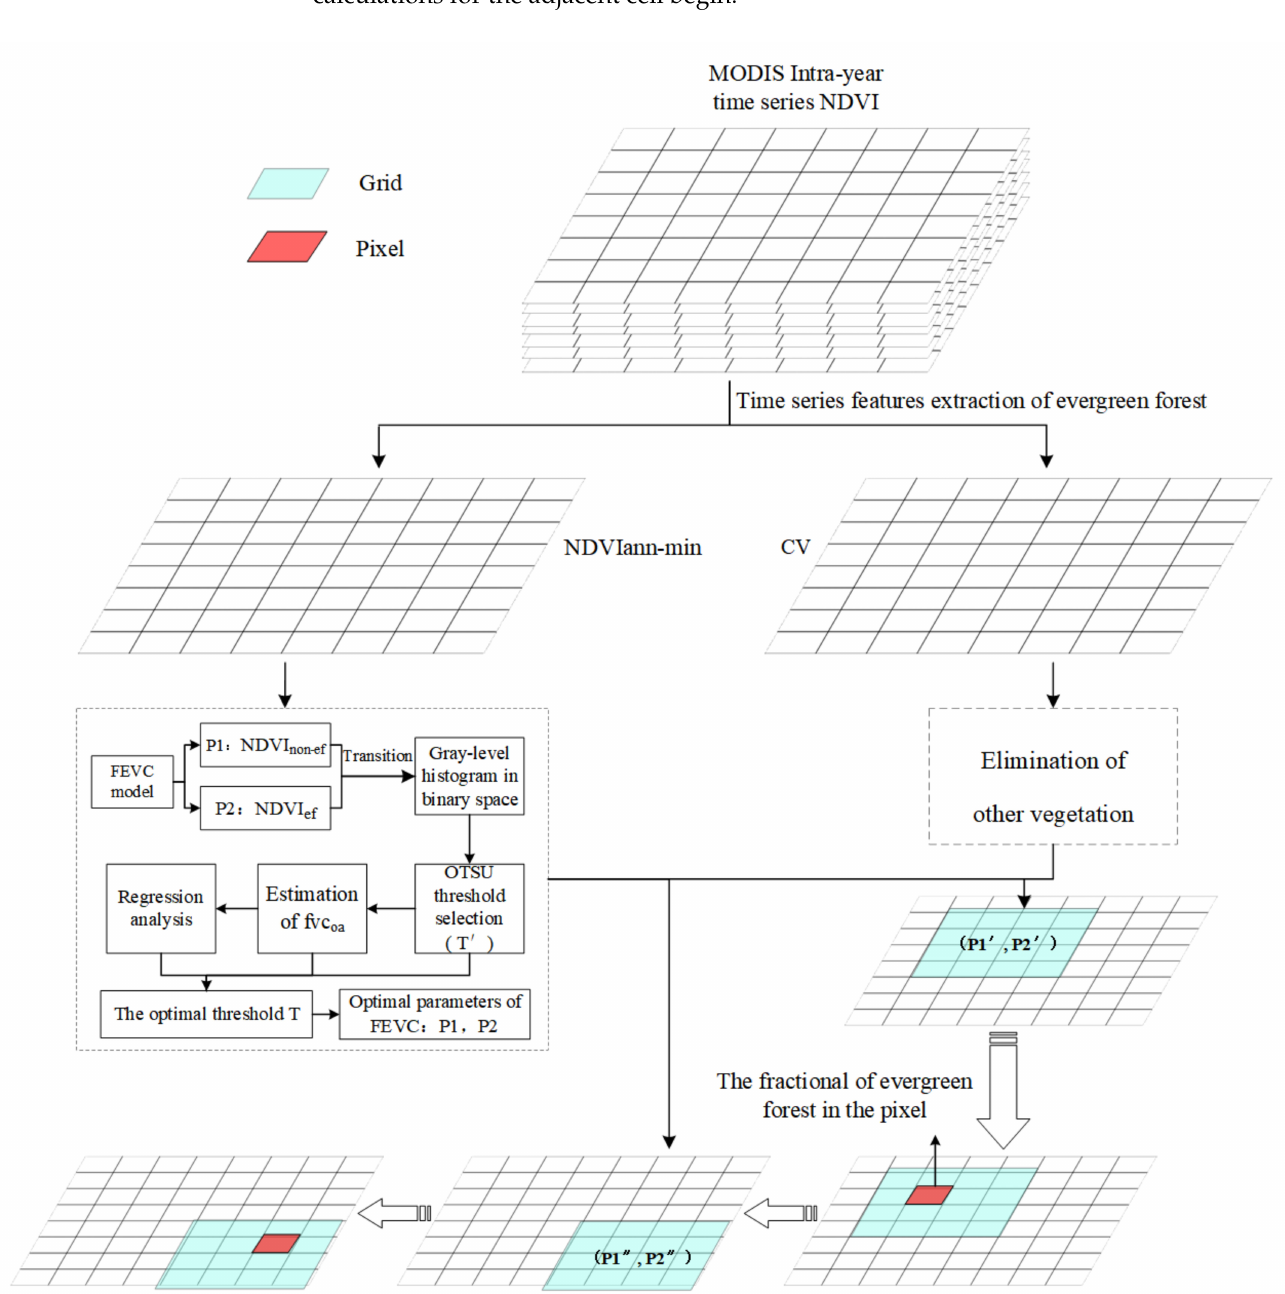
Figure 5. Schematic of the evergreen forest extraction process using the FEVC-SAP model. (P1 (cid:48) and P2 (cid:48) represent the optimal parameters in the grid respectively; and P1 (cid:48)(cid:48) and P2 (cid:48)(cid:48) represent the optimal parameters in another grid,